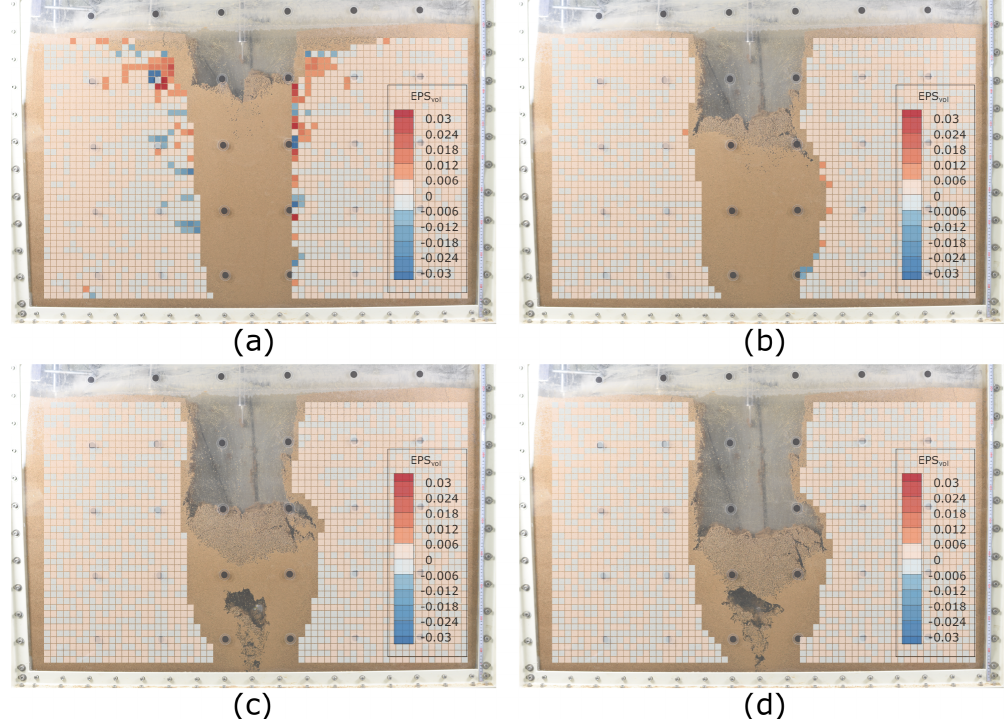
Figure 13. Volumetric strain inside the model ground for Test 3 during the water drainage stage: (a) 0–30s, (b) 30–60s, (c) 60–90s, and (d) 90–120s.